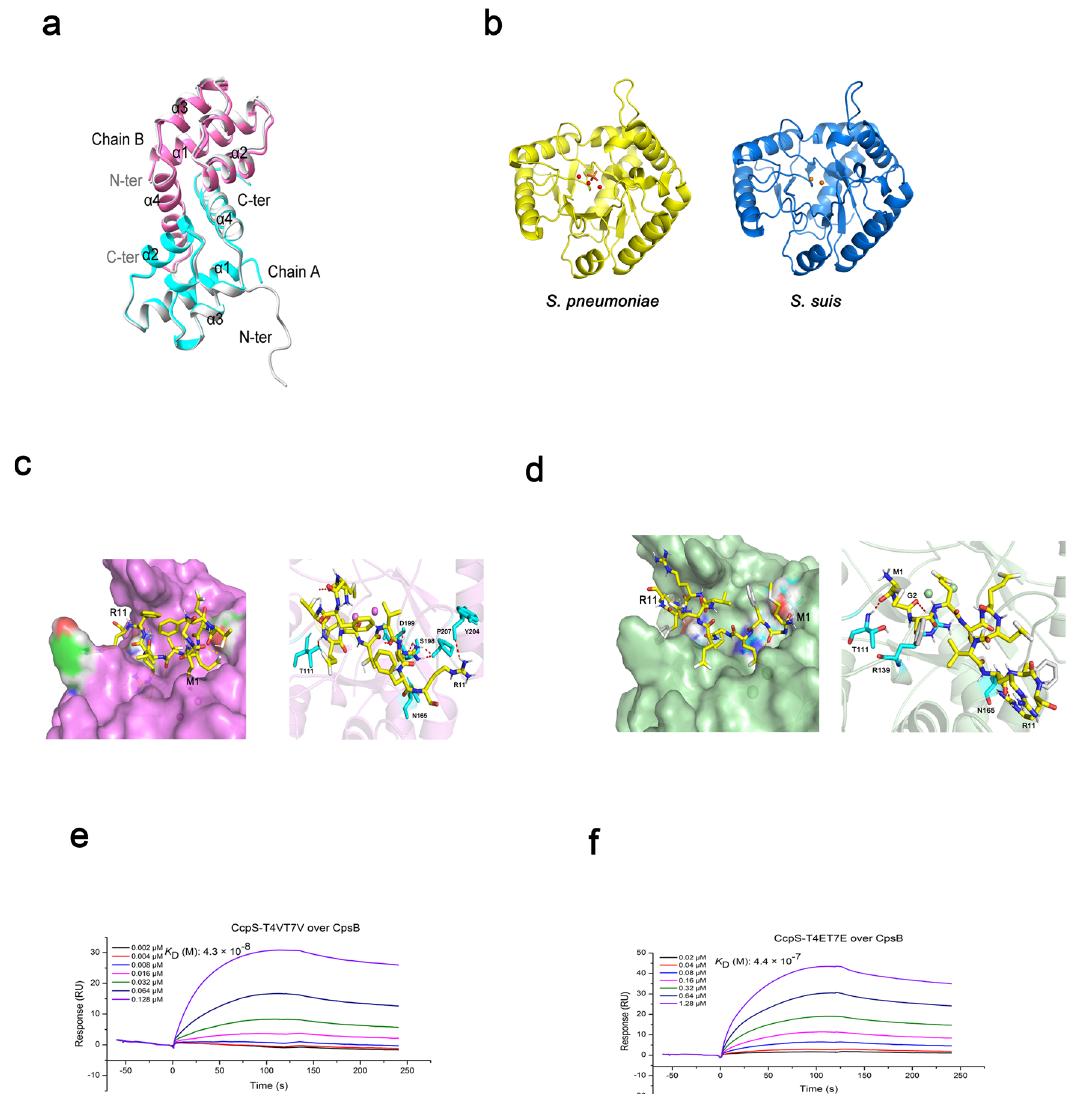
Fig. 5 | The CcpS af fi nity to CpsB is tuned by phosphorylation. a Superimposition of CcpS and its variant CcpS-T4ET7E (gray) X-ray crystal struc- ture,RMSDbetween70prunedatompairsis0.398angstroms. b Homologymodel buildingof S.suis CpsB(right)wasperformedaccordingtothesequencealignment with the S. pneumoniae Cps4B (PDB ID: 2WJF) (left). c Surface representation of putative-binding pocket of S. suis CpsB with ligand CcpS N (N means 1 – 11 amino acids residues at N-terminus of CcpS) shown in yellow sticks (left panel). Detailed interactionsofligandCcpS N withCpsBandresiduescriticalforligandbindingwere shownascyansticksandCcpS N wasshownasyellowsticks.Thehydrogenbondwas shown as red dashed lines (right panel). d Surface representation of putative-